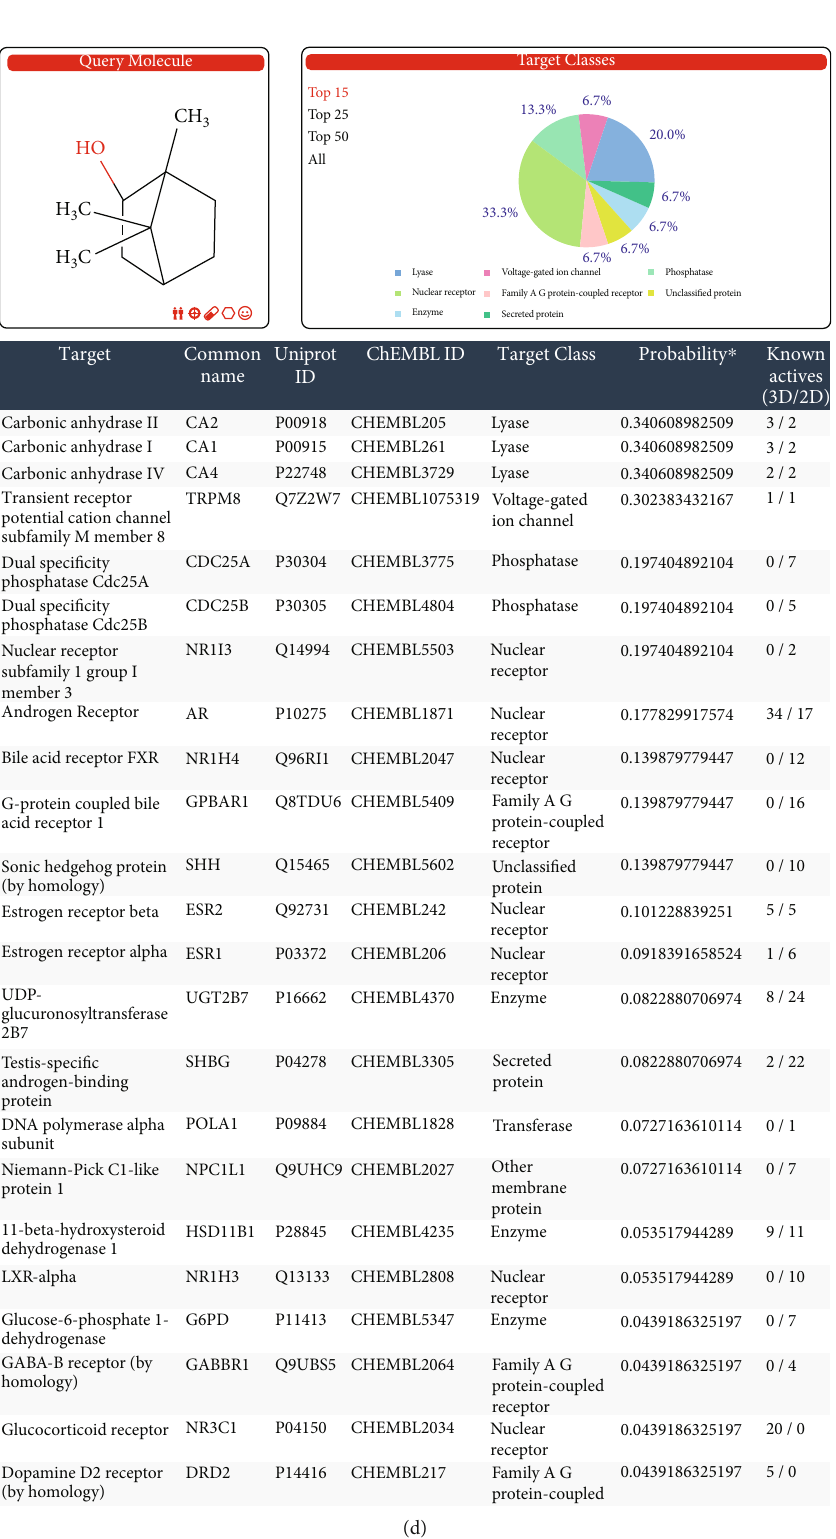
Figure 6: Results of the target sites prediction in human cells: (a) Linalool (3,7-dimethylocta-1,6-dien-3-ol; SMILE: CC(O)(C=C)CCC=C(C)C. B) Eugenol (4-Allyl-2-methoxyphenol; SMILE: COC1=CC(CC=C)=CC=C1O. (c) Limonene (1-methyl-4-(1-methyletenyl)-cyclohexene; SMILE: CC1=CCC(CC1)C(=C)C. (d) Borneol ([(2 R )-1,7,7-trimethyl-2-bicyclo[2.2.1]heptanyl] formate; SMILE: CC1(C2CCC1(C(C2)O)C)C. Green bars indicate the estimated probability that a protein could be an actual target of the secondary metabolite, at less probability the lesser it is that an actual target is